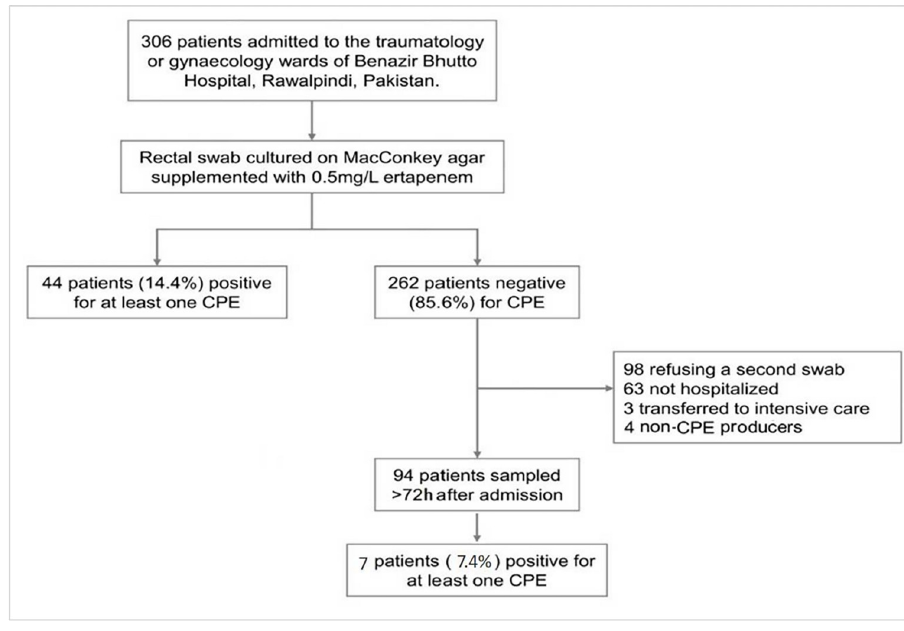
Fig 1. Flowchart of the